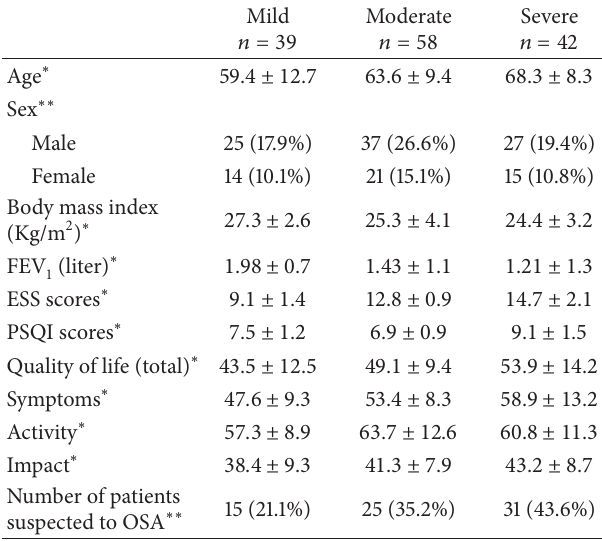
Table 1: Major characteristics of the studied patients divided by severity of their